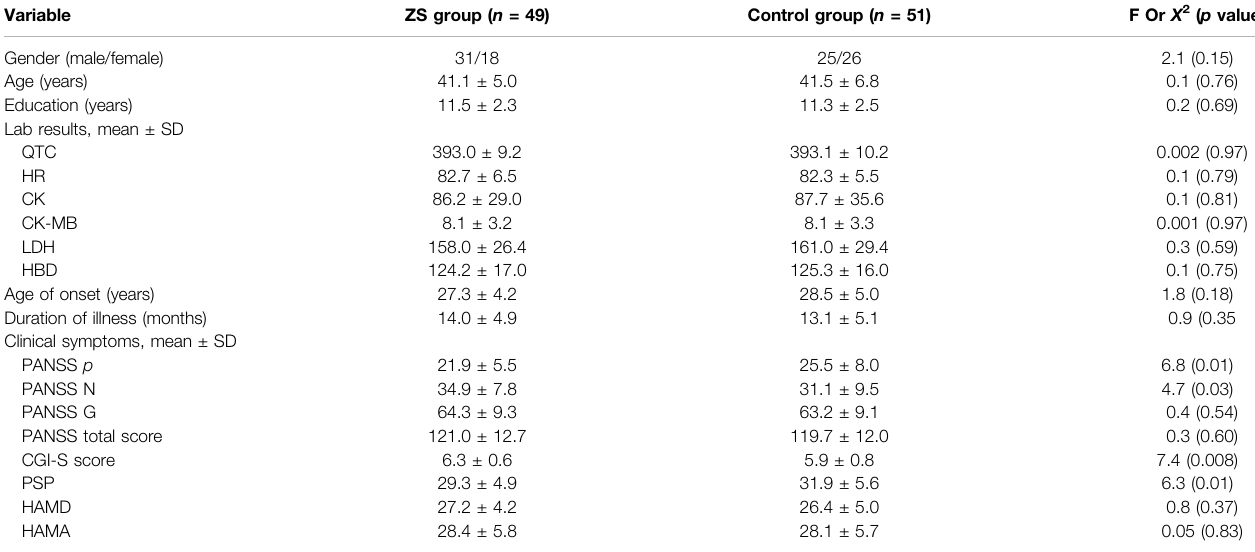
TABLE 1 | Demographic characteristics and clinical data in combination therapy group (ZS) and control group (mean ± standard